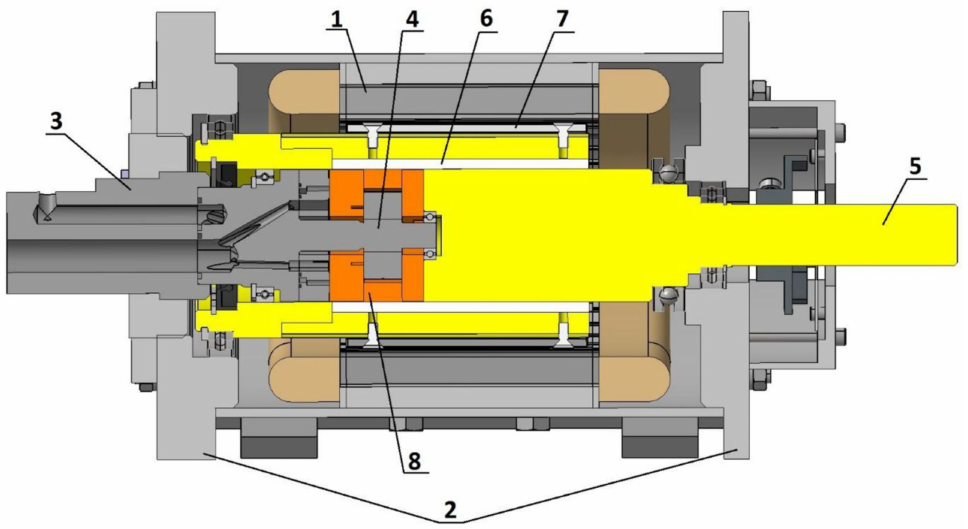
Figure 5. Integrated BLDC motor-vane pump assembly. 1—stator core, 2—covers, 3—suction and discharge channels, 4—internal part with vanes, 5—rotor of brushless DC motor, 6—nonmagnetic bushing, 7—neodymium magnets, 8—pump cartridge [6]. (Copyright by ASME, 2017).